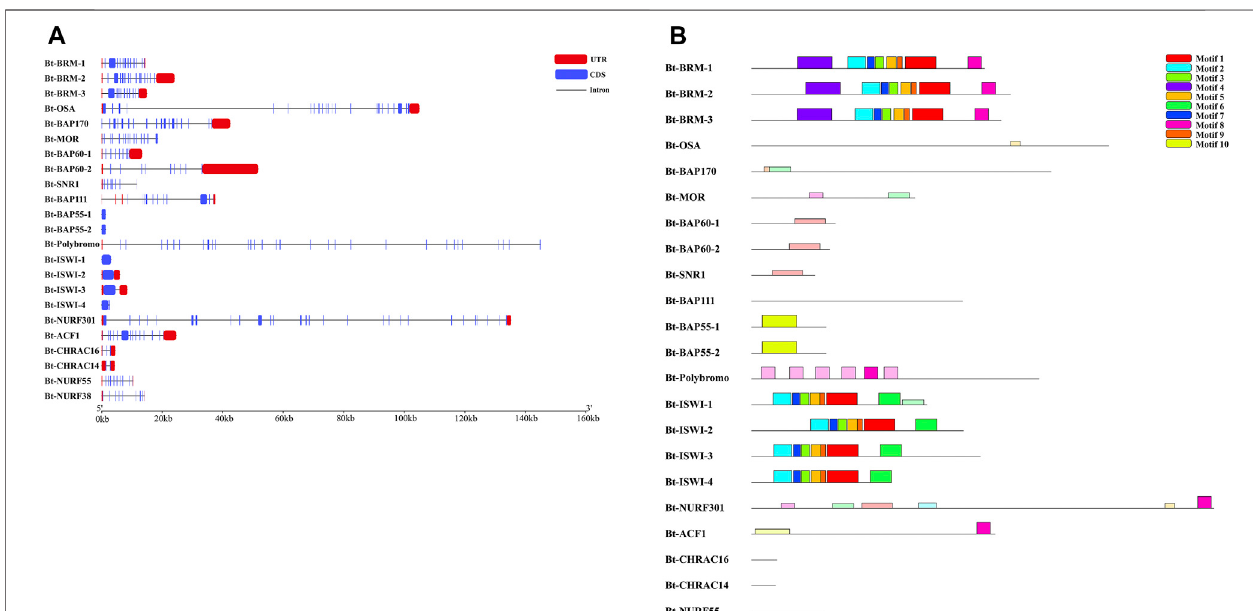
FIGURE 1 | Gene structure and conserved motif analysis of remodelers in Bemisia tabaci . (A) Exon/intron organization of remodelers. Red boxes represent UTR, blue boxes represent exons and black lines represent introns. (B) Distribution of conserved motifs in remodelers. Ten putative motifs are indicated in different colored boxes. For details of motifs refer to Table 2